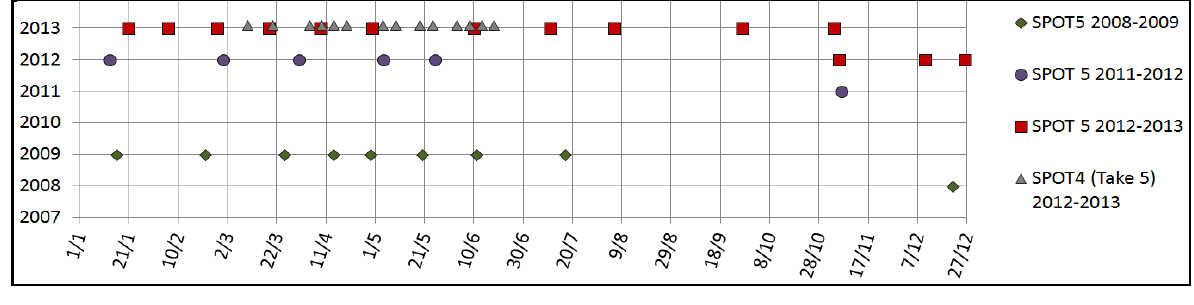
Figure 2. Acquisition dates of the SPOT